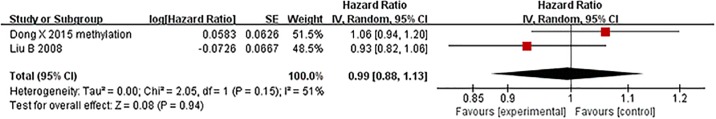
Forest plot of hazard ratios (HRs) of OS in the random-effect model.The HR of overall survival time of TIP30 promoter methylated cancer patients was compared with TIP30 promoter unmethylated cancer patients. A HR = 0.99 implies no significant differences in OS for methylation of the TIP30 promoter.